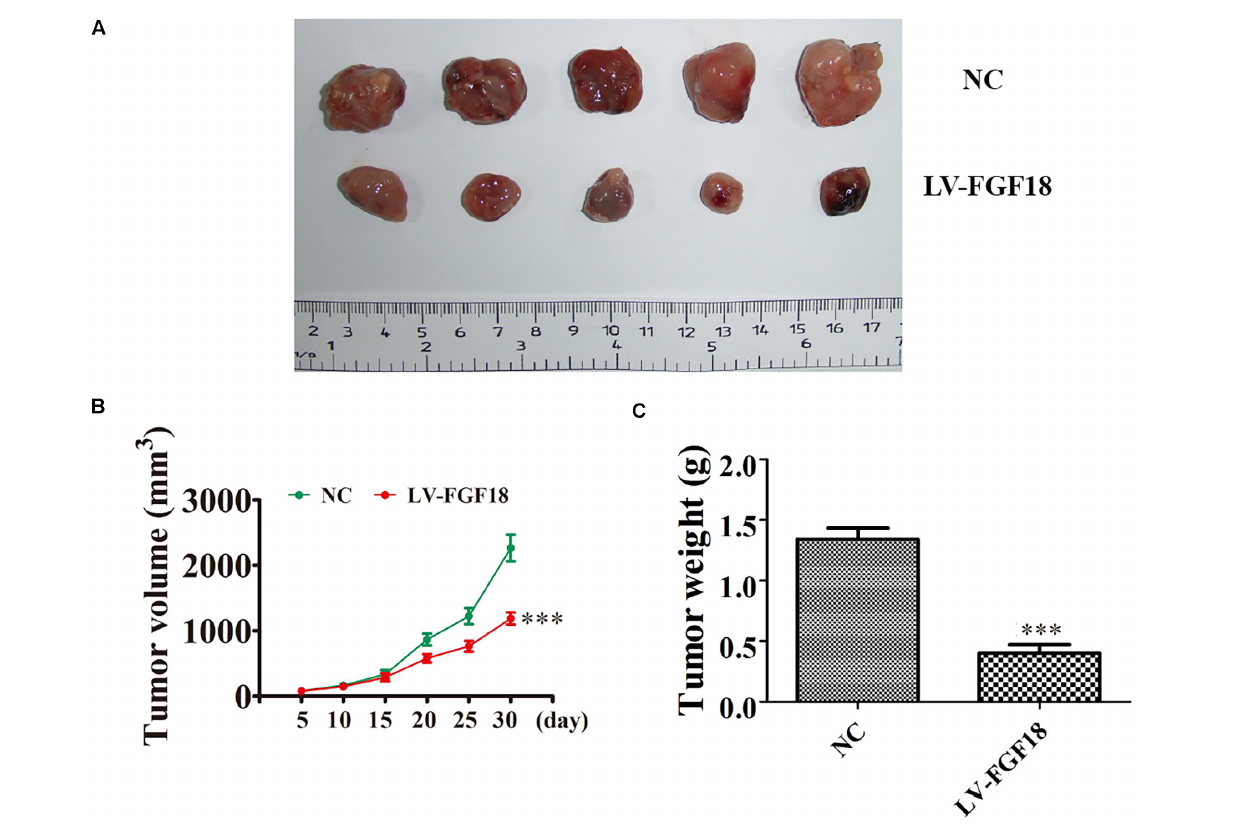
FIGURE 6 | In vivo xenograft mice model validates FGF18 as a tumor suppressor in ccRCC cell. (A) Representative photographs of 786-O tumor formation in the xenograft nude mice model. (B) Summary of the tumor volume in mice that were measured weekly. Data are presented as mean ± SD. ∗∗∗ p < 0.001 versus NC. (C) Tumor weight was measured 30 days post-injection. Data are presented as mean ± SD, ∗∗∗ p < 0.001 versus NC.